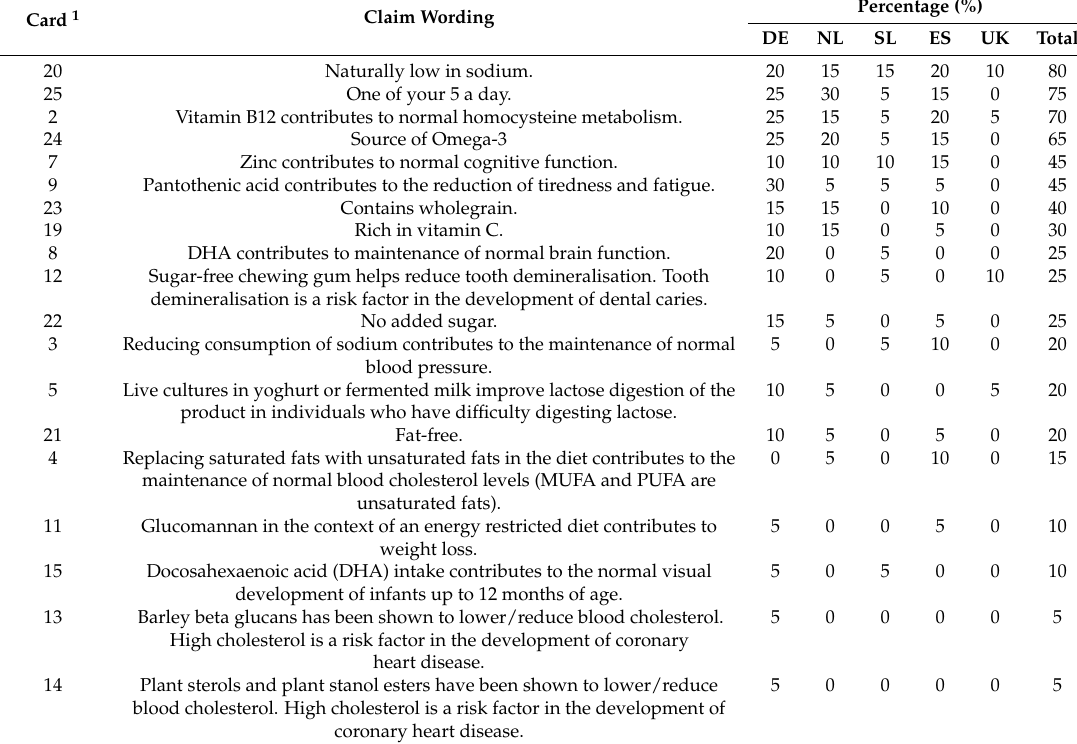
Table A3. Frequency of stimuli cards placed in Structured Sort Group 7 “Don’t know” by country. Card 1 Claim Wording